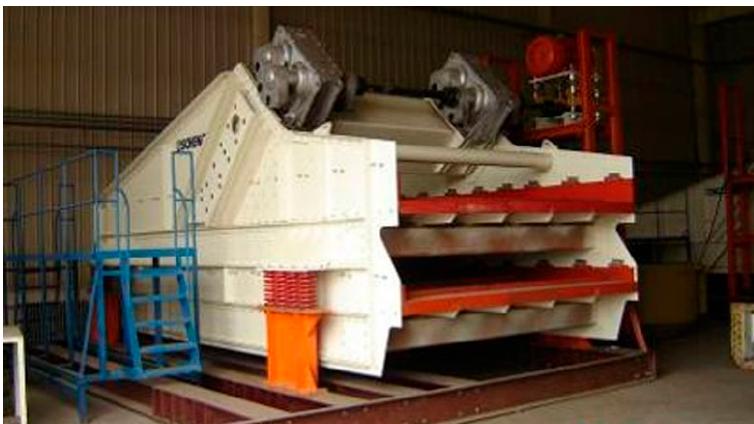
Figure 1. The SLK3661W double-deck linear mining vibrating screen, unloading side view.